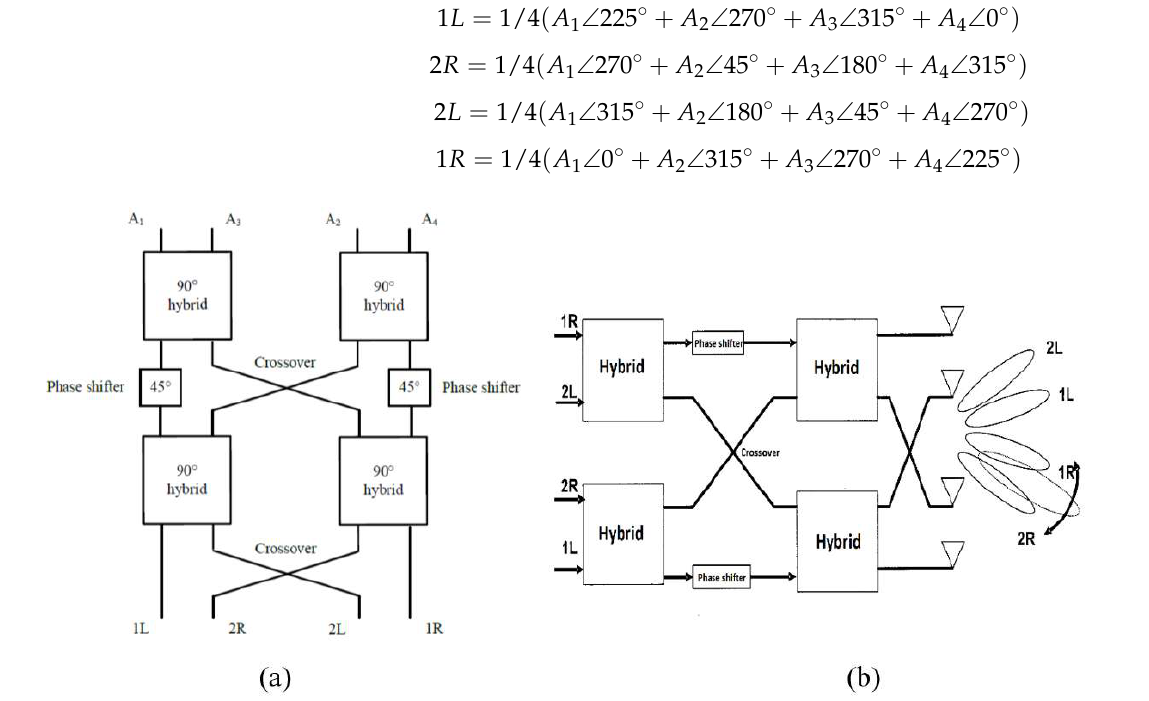
Figure 6. ( a ) A 4 × 4 Butler matrix block diagram, ( b ) Beam selection.